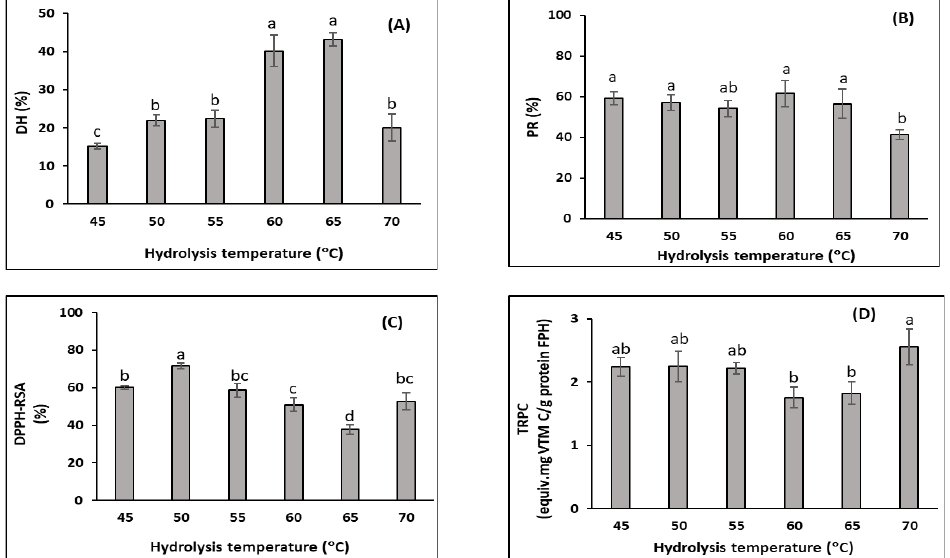
Figure 3. Effect of hydrolysis temperature (°C) on FPH properties from the DM-FPI (trial 2), including: ( A ) degree of hydrolysis (DH, %); ( B ) protein recovery (PR, %); ( C ) DPPH radical scavenging activity (DPPH-RSC, %); and ( D ) total reducing power capacity (TRPC, equiv. mg vitamin C/g FPH protein). The hydrolysis reaction was carried out for 3 h with an enzyme ratio of 3%. Different lowercase letters show significant differences at a significance level of p <